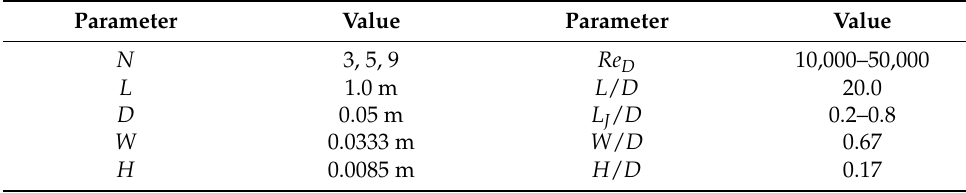
Table 1. Dimensional and non-dimensional parameters of swirling air configurations.